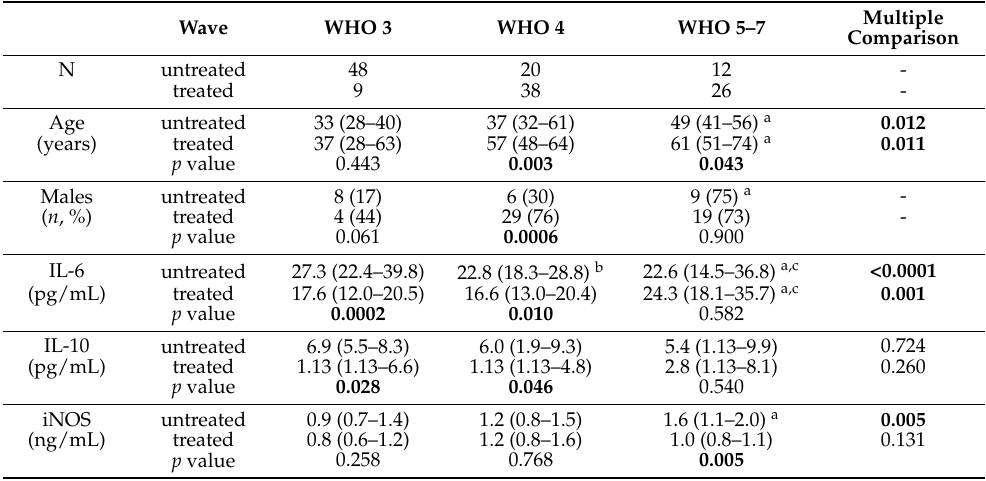
Table 2. Comparison of serum cytokine levels and iNOS in 153 patients of 2nd wave with different severity according to worst WHO stage and untreated or treated with corticosteroid/azithromycin before hospitalization. Median and interquartile